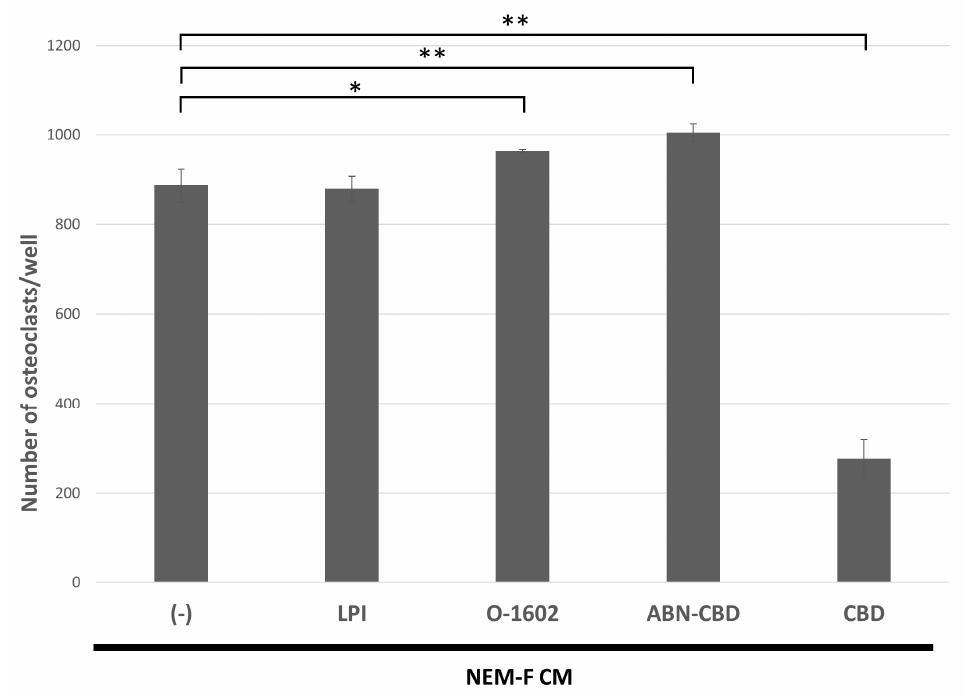
Figure 5. The effect of GPR55 antagonists or agonists on osteoclastogenesis induced by the culture supernatant of NEM-F cells. The number of osteoclasts induced by the culture supernatant of NEM-F cells supplemented with GPR55 antagonists, such as CBD, or agonists, such as LPI, O-1602, and ABN-CBD, relative to those without supplementation. ** p < 0.01, * p < 0.05 (one-way ANOVA with the Dunnett’s method).